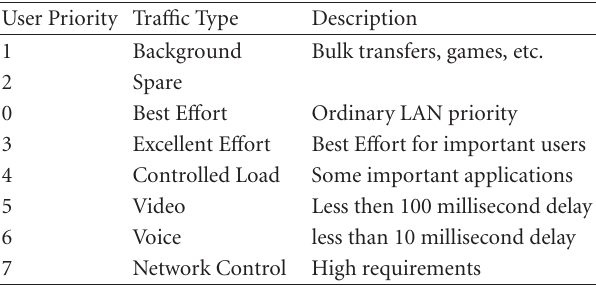
Table 1: User priority to tra ffi c class